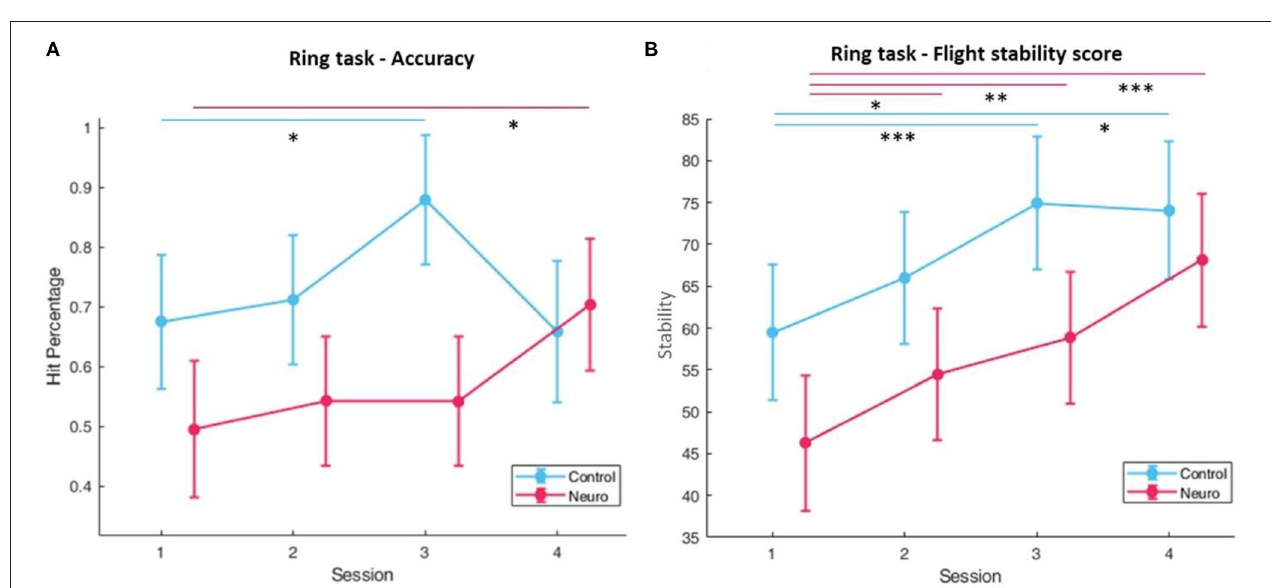
FIGURE 14 | (A) Behavioral performance as measured by the accuracy, or ratio of rings successfully flown through for the ring task. A significant interaction between condition and session was found. (B) Behavioral performance calculated by plane orientation through rings. Both conditions significantly improved over time, but only neuroadaptive maintained that increase throughout all sessions (whiskers are SEM, * p < 0.05, ** p < 0.01, *** p < 0.001).